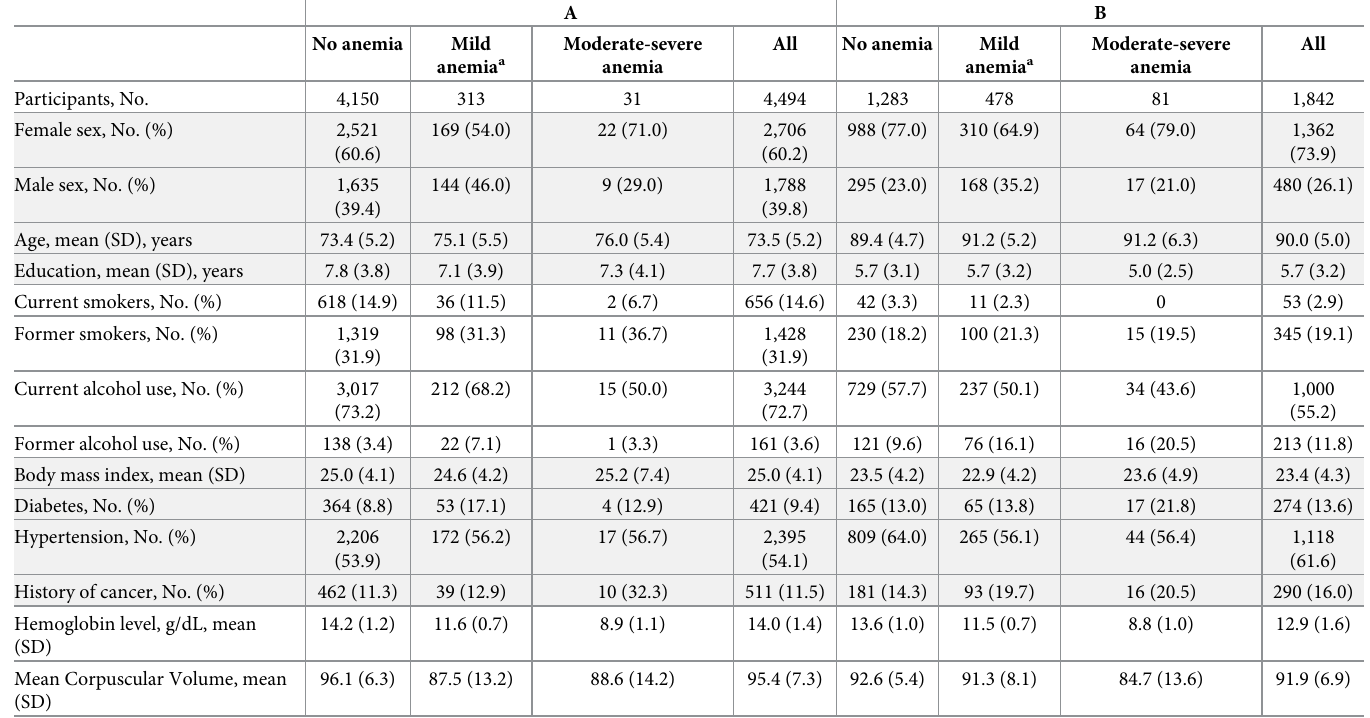
Table 1. A. Baseline characteristics of participants aged 65–84 years at blood sample from the Health and Anemia 65–84 population-based study. B. Baseline characteris- tics of participants aged 80 years or older at blood sample from two pooled population-based studies ( Health and Anemia 85+ and Monzino 80-plus